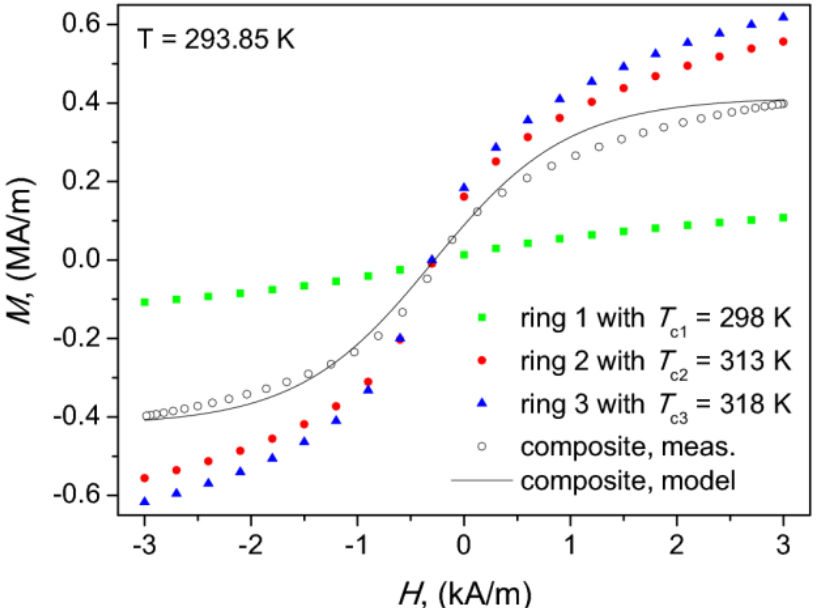
Figure 11. The measured descending branches of hysteresis loops of the composite core and its components at room temperature; additionally, the modeled descending branch for the composite core is shown as solid line.